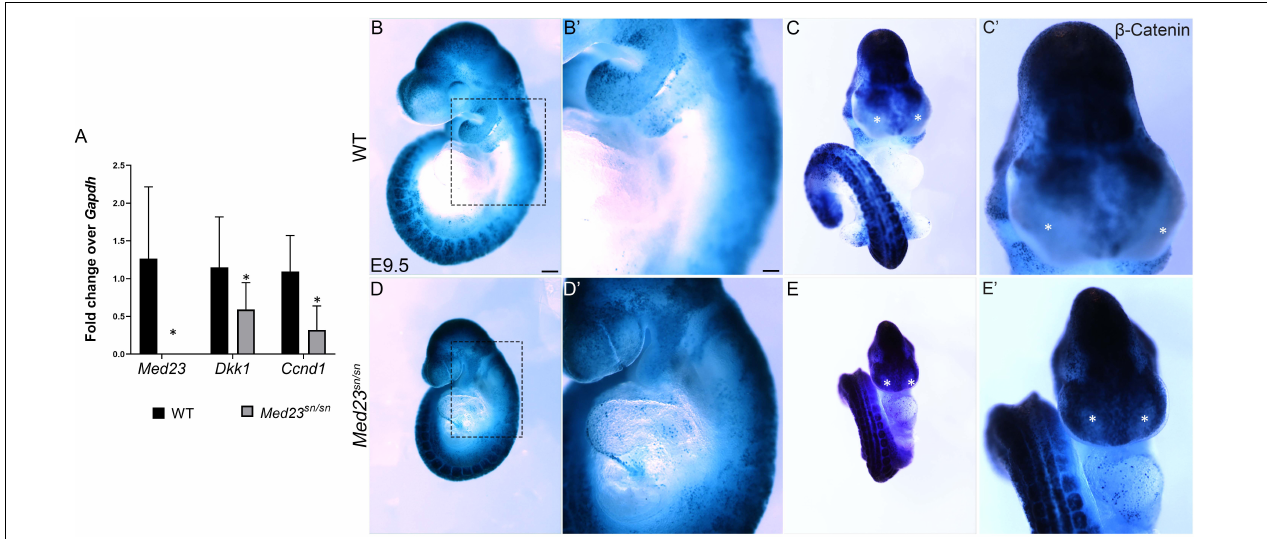
FIGURE 5 | WNT signaling is upregulated and ectopically expressed in the lateral nasal processes of Med23 sn / sn embryos. (A) qPCR analysis of cDNA obtained from E9.5 wild-type and Med23 sn / sn littermate embryos shows a reduction in the levels of Med23 , Dkk1, and Ccnd1 . (B–E (cid:48) ) Lateral and frontal images of control BATGal and Med23 sn / sn ; BATGal embryos reveal an increase in WNT signaling in the frontonasal processes at E9.5. The lateral nasal processes, which are usually devoid of active WNT signaling (*, asterisk, control) exhibit positive LacZ staining (WNT activity) in Med23 sn / sn embryos (*, asterisk, Med23 sn / sn ). (B (cid:48) –E (cid:48) ) are high magnification images of (B–E) . Scale bar for (B–E) is 450 um, (B (cid:48) –E (cid:48) ) is 100